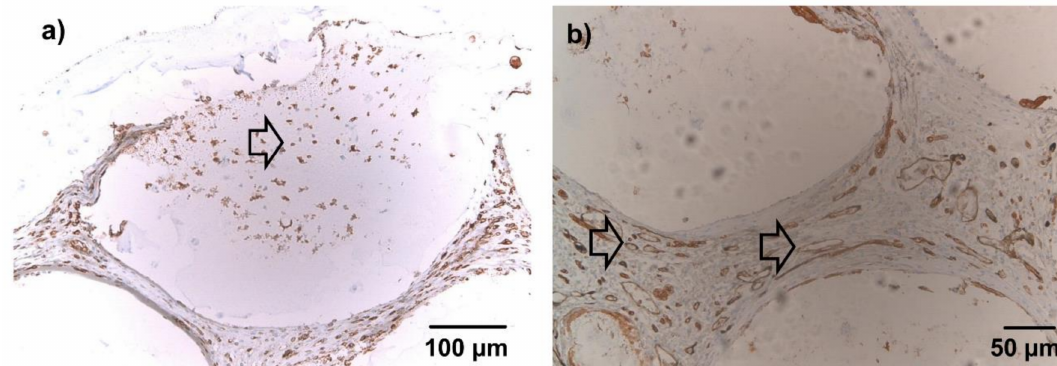
Figure 6. Lectin immunohistochemical staining, 10 × ( a ) and 20 × magnification ( b ), representative images (not all groups are depicted). Brown cells = lectin-positive; blue cells = lectin-negative (counterstained with hemalaun). ( a ) After 1 week, lectin-positive cells were diffusely dispersed in the connective tissue between beads. A fraction of the infiltrating cells stained clearly positive for lectin (arrow). ( b ) After 4 weeks, the connective tissue between the microbeads was highly vascularized (arrows). No differences were evident between groups with nBG and without nBG in qualitative microscopic